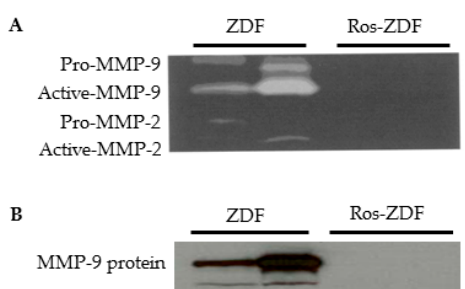
Figure 4. Effect of rosiglitazone on urinary gelatinolytic activity and MMP-9 protein in ZDF rats. ( A ) Representative gelatin zymograph shows a decrease in urinary MMP-9 and MMP-2 activity in ZDF rats following rosiglitazone treatment; ( B ) Western blot confirms a decrease in urinary MMP-9 protein in rosiglitazone-treated ZDF rats compared to vehicle-treated ZDF ones.